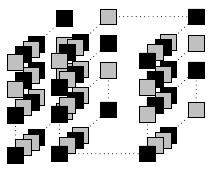
Figure 4. A Sparse Tensor with no value denoted as black cells